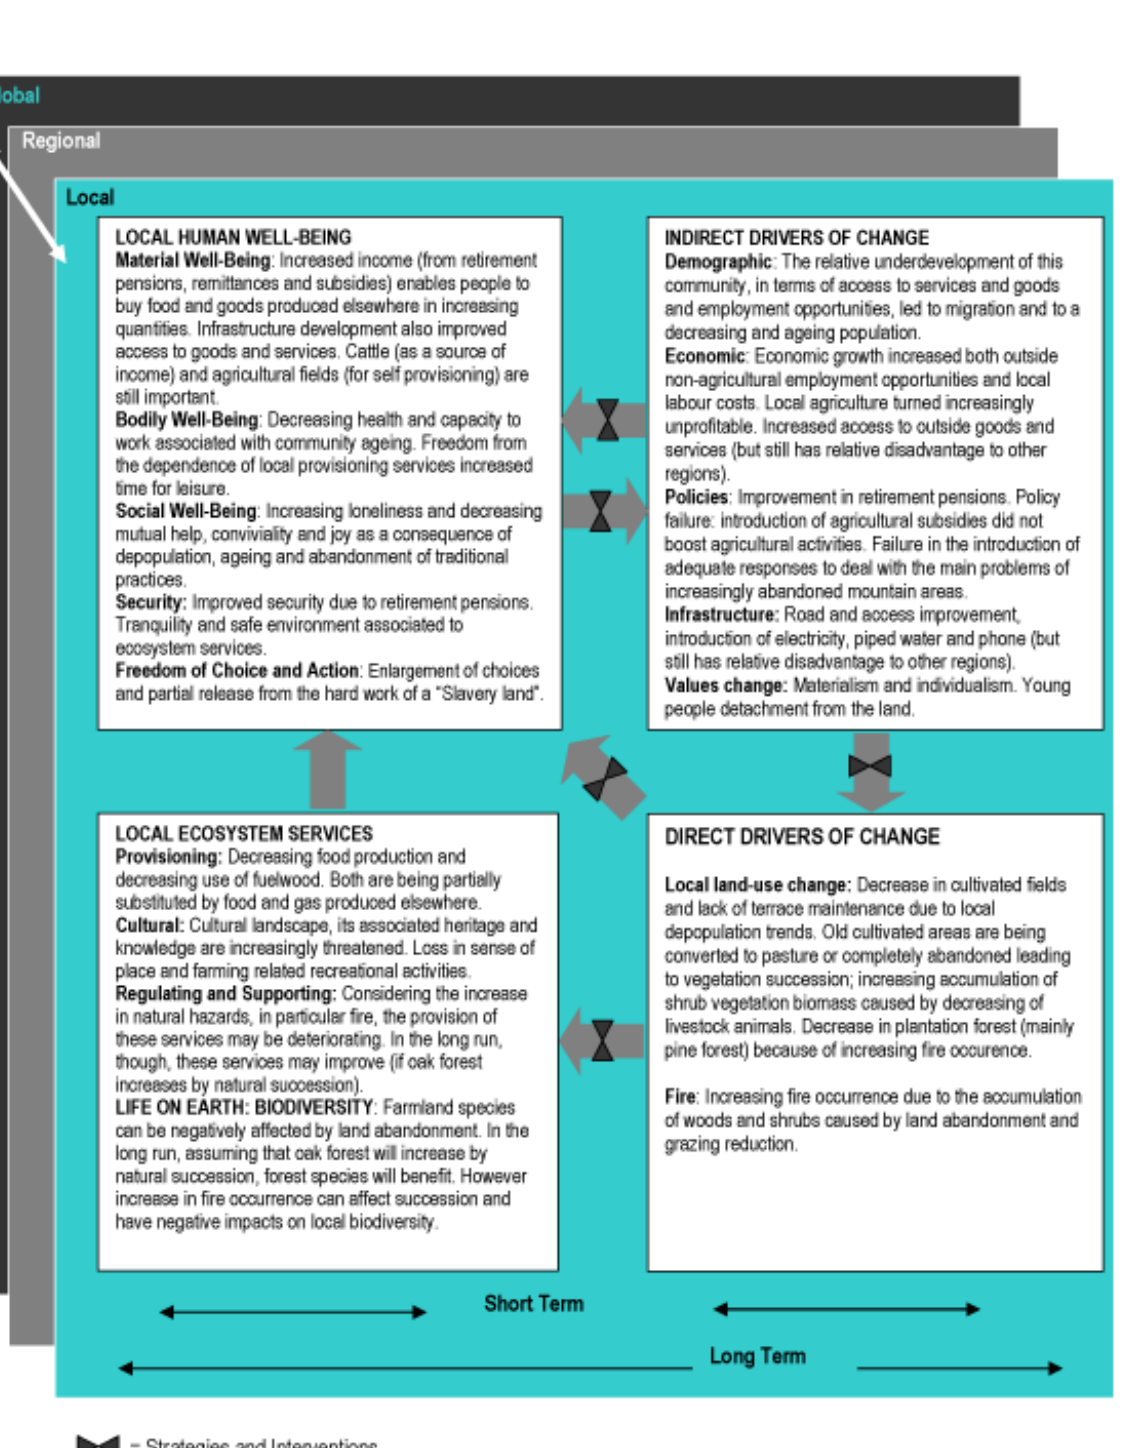
Fig. 7 . The Millennium Assessment conceptual framework applied to